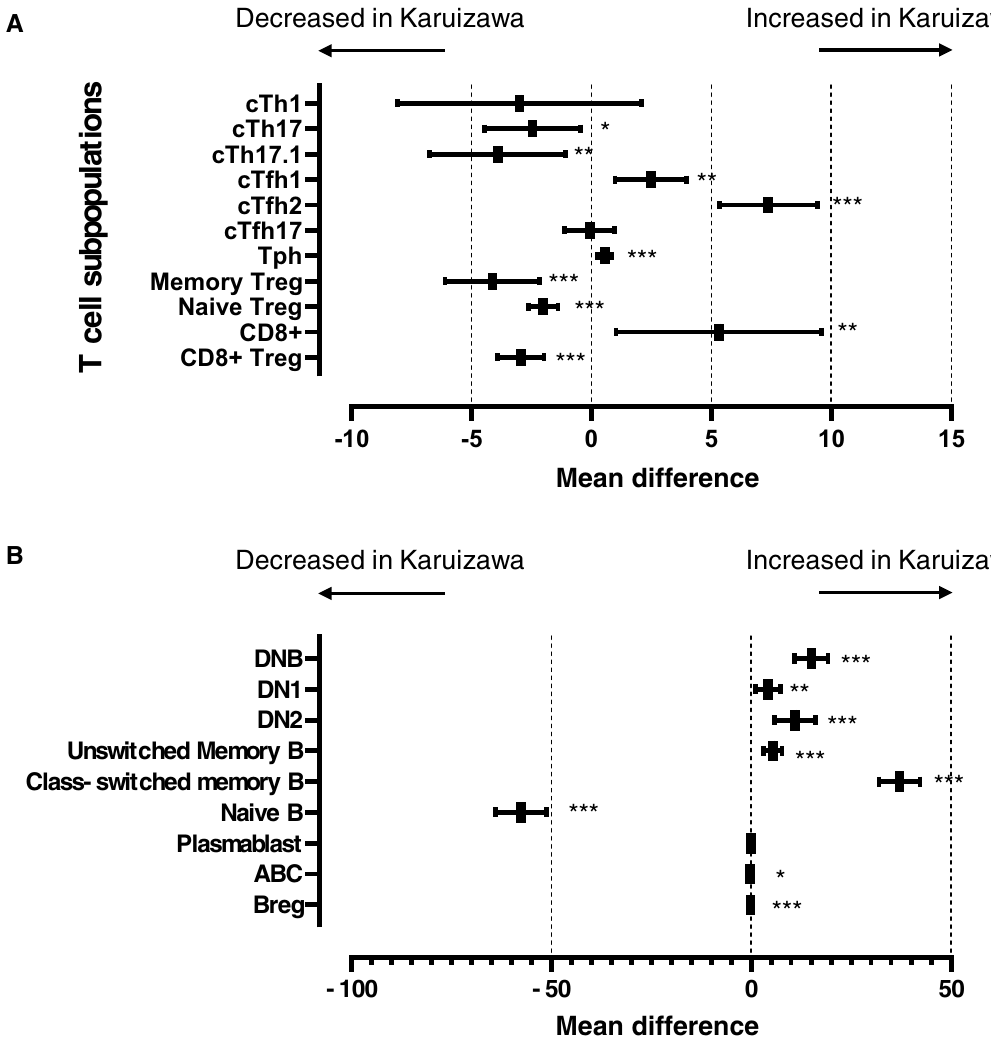
Figure 4. Comparison of subpopulations of peripheral blood T and B cells in HCs after adjustment with propensity score weighting. Inverse probability weighting adjustments with propensity scores were performed to control for biases caused by the imbalance of potential confounding factors in comparison of subpopulation in T cells ( A ) and B cells ( B ) of PBMC collected from HCs in two hospitals. The graph shows the mean difference with 95% confidence intervals for each subpopulation after IPW adjustment. Positive or negative numbers represent increase or decrease of the subpopulations in the patients in Karuizawa, respectively. Statistical significance was defined as * P < 0.05, ** P < 0.01, *** P < 0.001, and **** P <